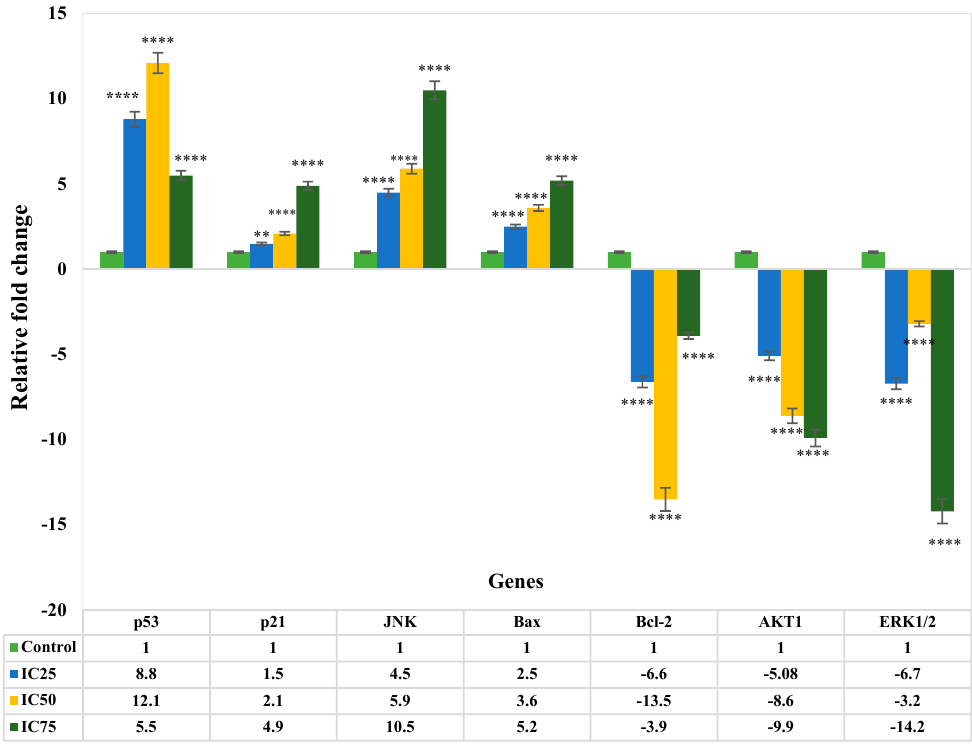
Figure 4. Gene expression levels in MCF-7 cells following treatment with ZnO Ps. Relative fold change of gene expression in ZnO NP-treated cells at 24 h, in comparison to the control. The values represent the mean ± STD ( n = 3). * p ≤ 0.0.5; ** p ≤ 0.0; *** p ≤ 0.001; **** p ≤ 0.0001.